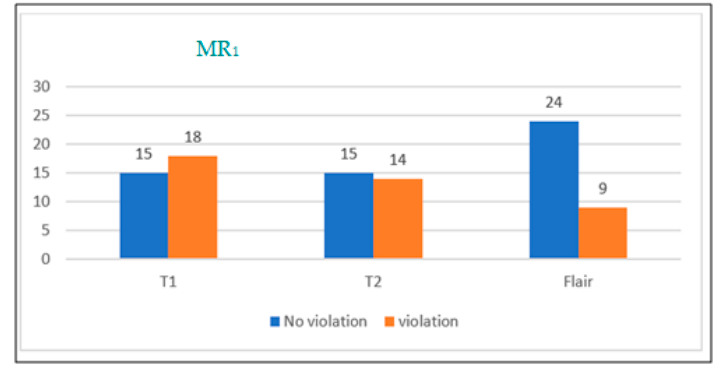
Figure 7. No. of test cases violating MR 1 for T1, T2, and flair images.